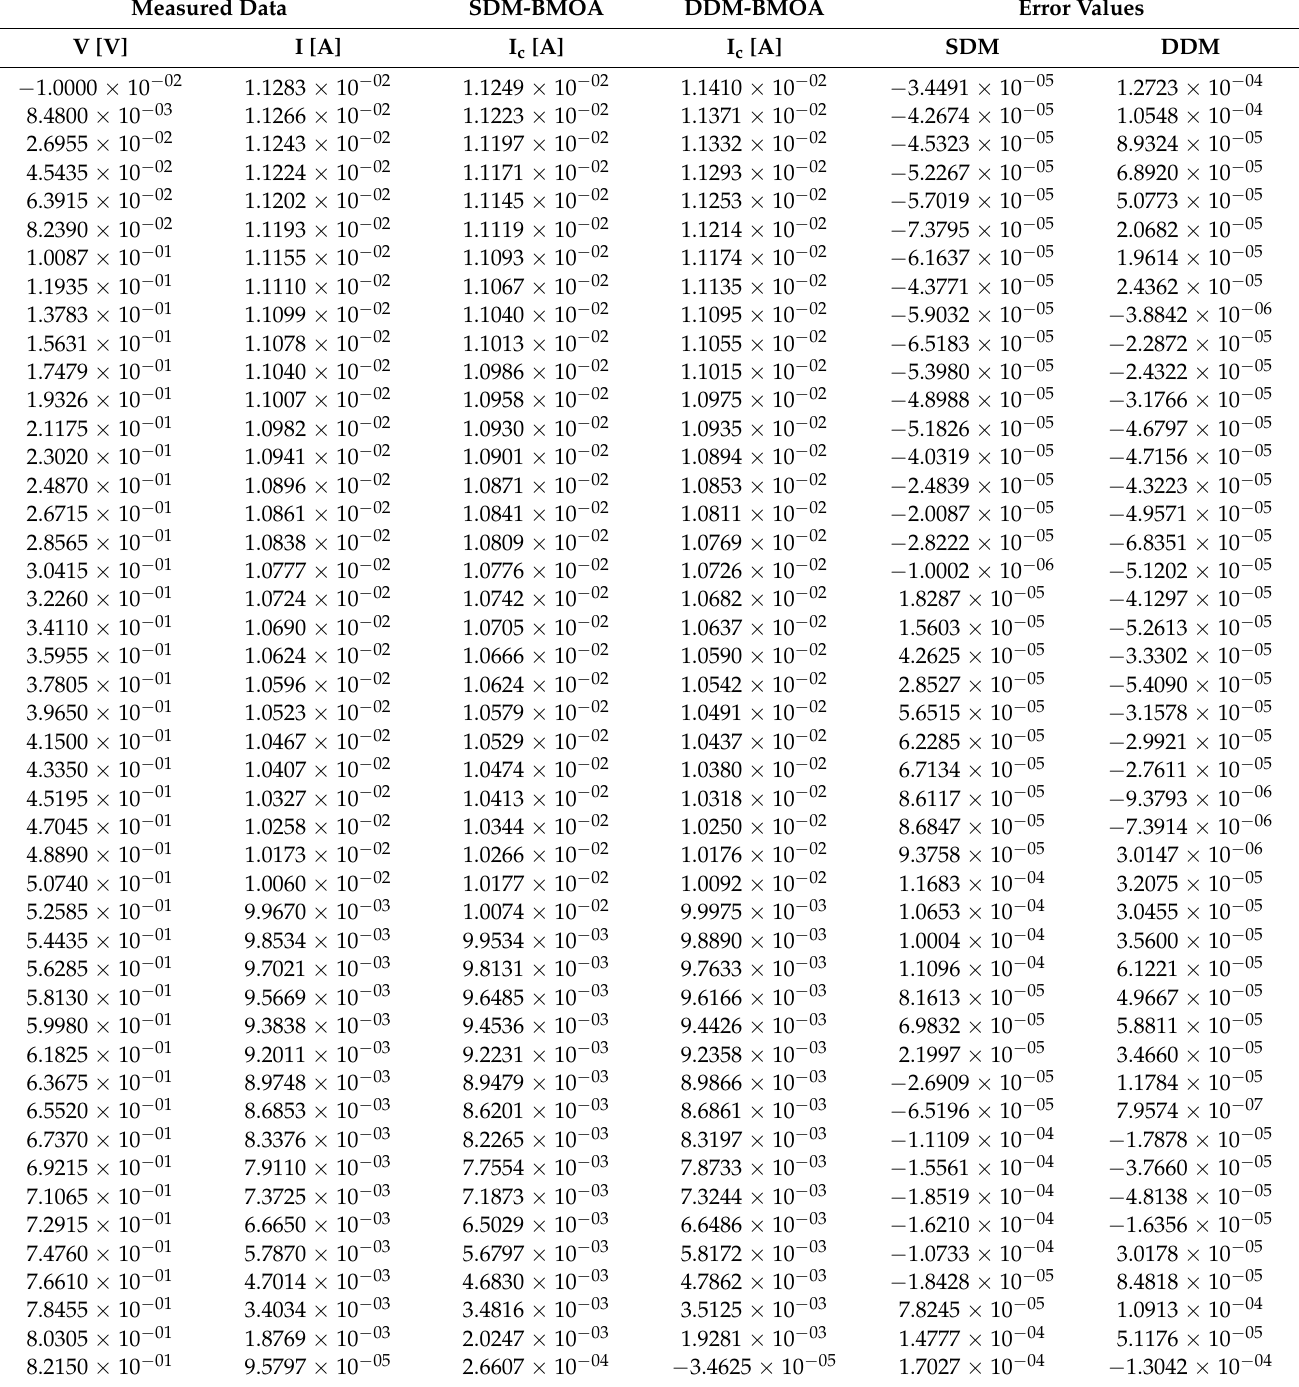
Table 5. (I, V) points of aSi photovoltaic